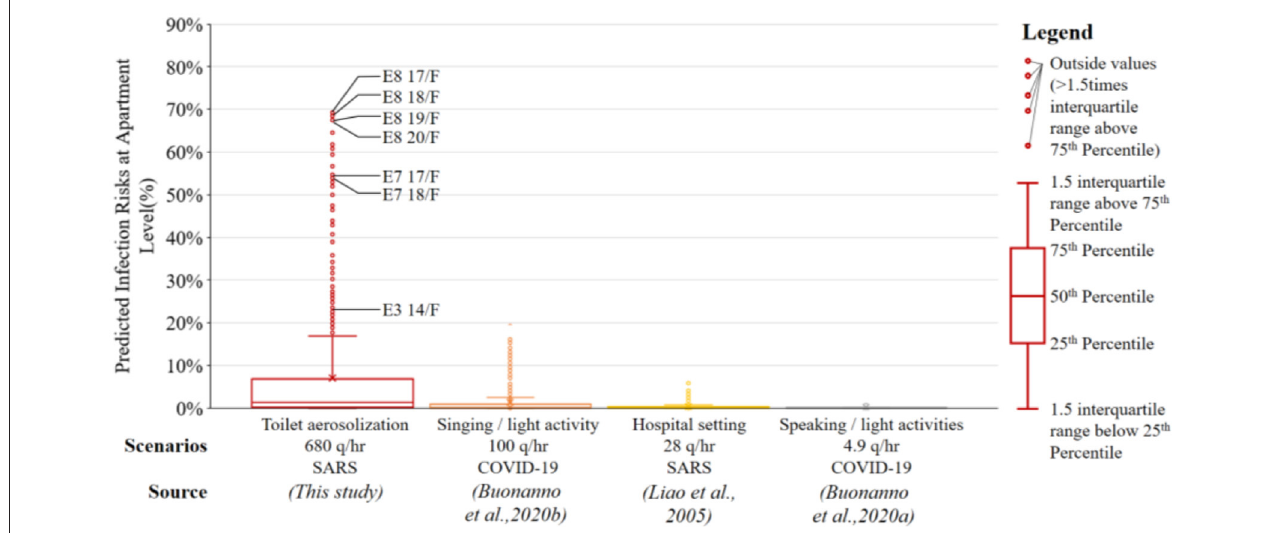
FIGURE 11 | A boxplot of predicted infection risks at apartment level with various quanta emission rates from the primary patient in the SARS outbreak in Amoy